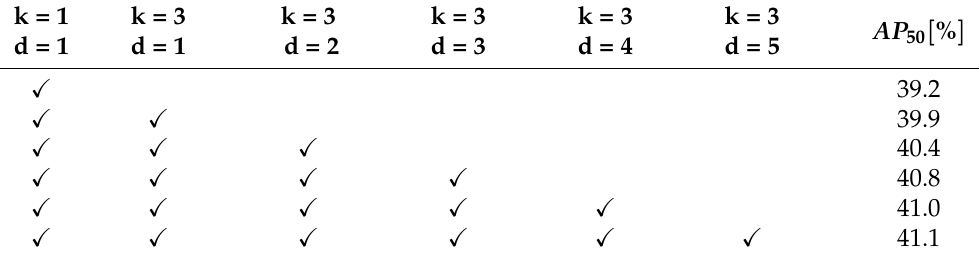
Table 1. The effectiveness of CC under different configurations of dilation rate k and kernel size k